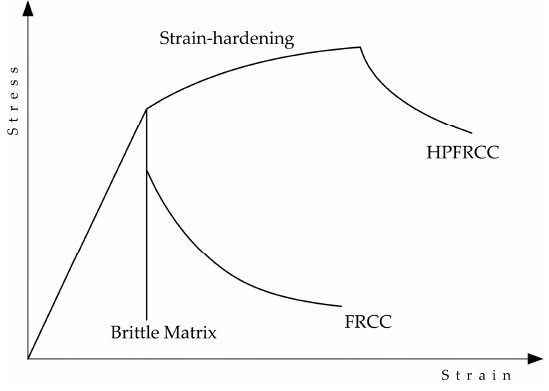
Figure 1. Failure behavior of plain cement matrix and fiber-reinforced cement matrices.